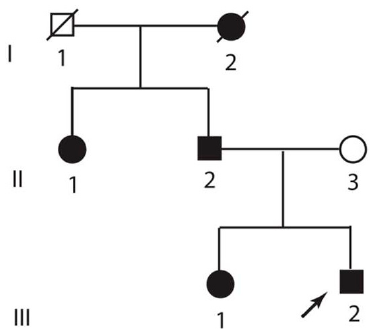
Figure 1. Pedigree of presented kindred: Roman numerals denote generation and Latin numerals denote individual subjects. The arrow indicates the proband.